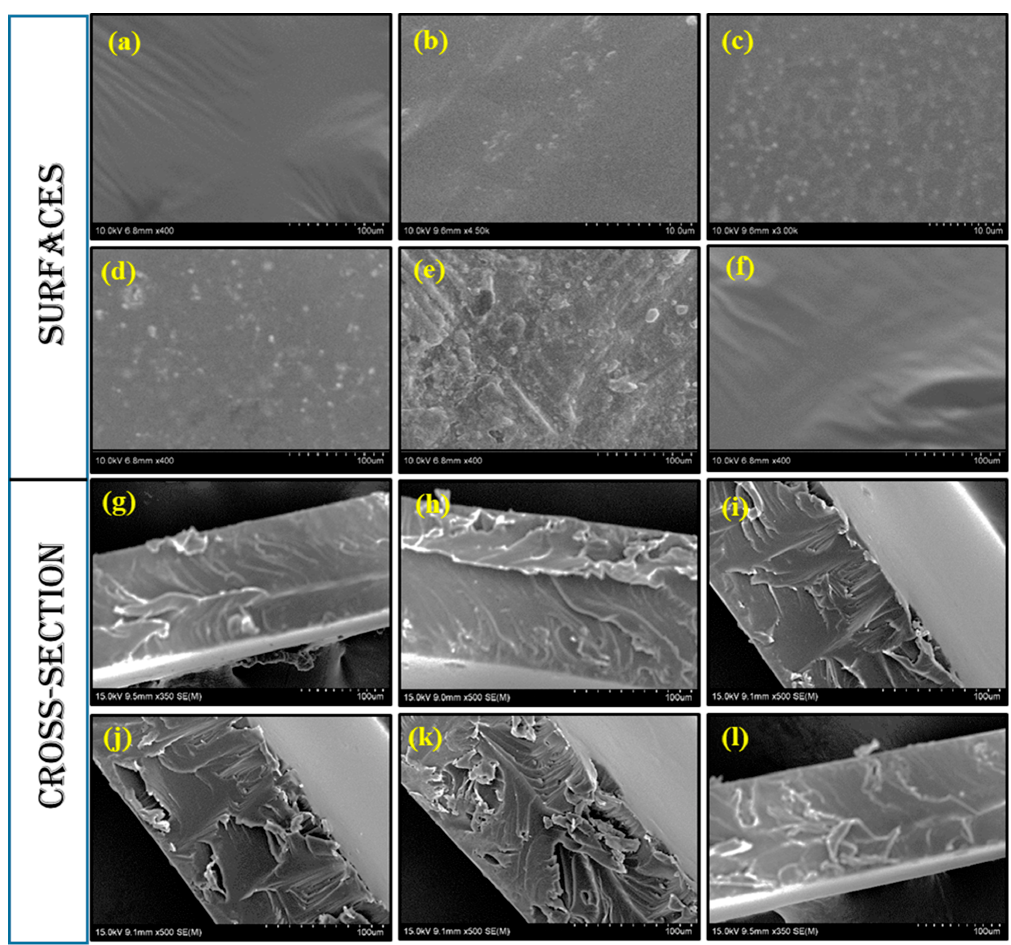
Figure 4. FE ‐ SEM images of poly(C ‐ st)/AC films: poly(C ‐ st)/AC (100/0) ( a , g ); poly(C ‐ st)/AC (80/20) Figure 4. FE-SEM images of poly(C-st)/AC films: poly(C-st)/AC (100/0) ( a , g ); poly(C-st)/AC (80/20) ( b , h ); poly(C ‐ st)/AC (60/40) ( c , i ); poly(C ‐ st)/AC (40/60) ( d , j ); poly(C ‐ st)/AC (20/80) ( e , k ); and poly(C ‐ ( b , h ); poly(C-st)/AC (60/40) ( c , i ); poly(C-st)/AC (40/60) ( d , j ); poly(C-st)/AC (20/80) ( e , k ); and st)/AC (0/100) ( f , l ). poly(C-st)/AC (0/100) ( f , l